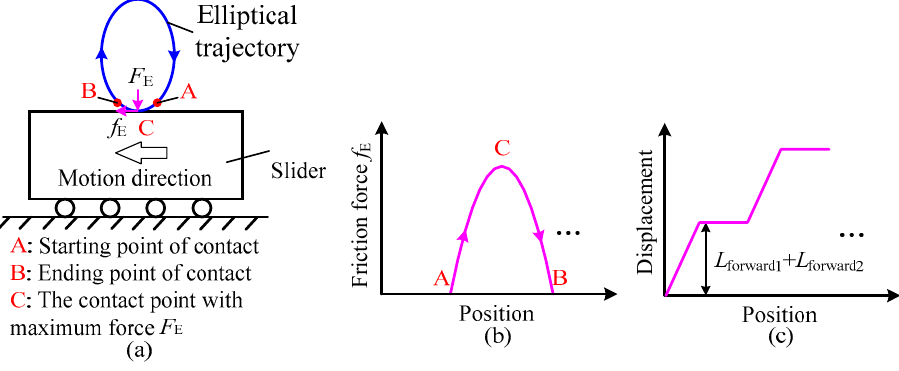
Figure 2. Schematic diagram illustrating the suppressing principle by employing the elliptical trajectory: ( a ) the contact driving process, ( b ) the relationship between the position of output end of flexure hinge mechanism and the friction force, and ( c ) the stepping displacement.